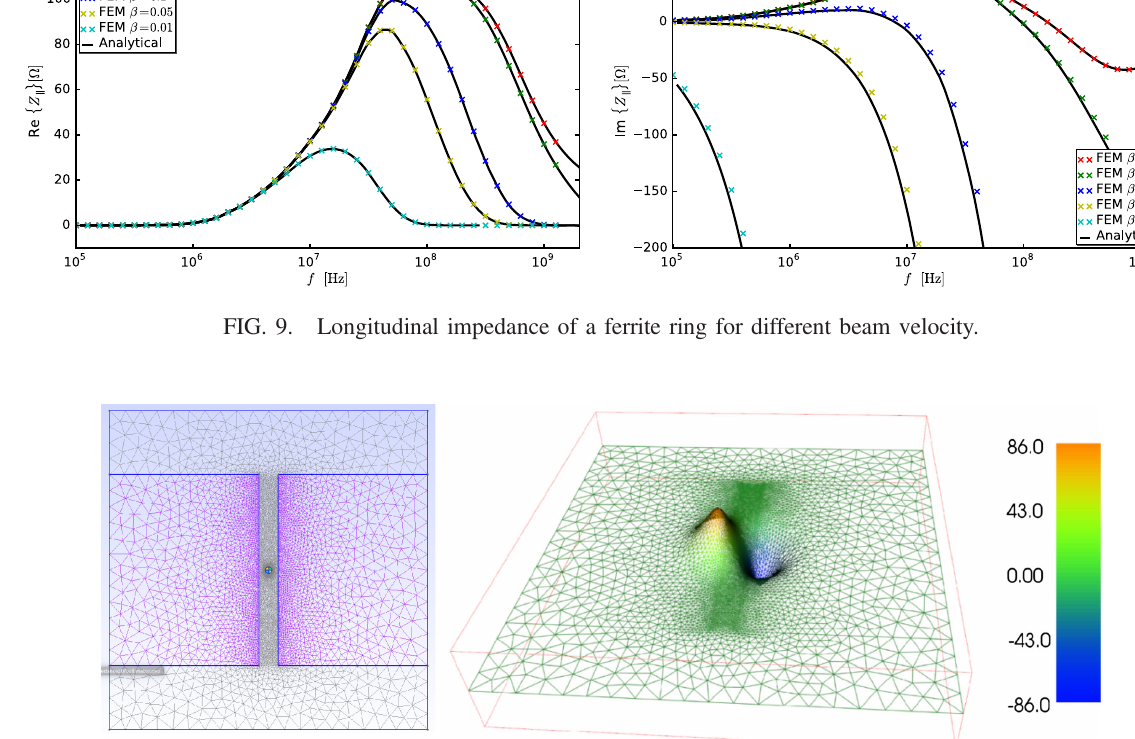
FIG. 10. Resistive collimator with 3 mm half gap and 3 cm half jaw height in a 10 cm × 10 cm bounding box. Mesh from GMSH (left), where the carbon jaws are in magenta and vacuum is in grey. The real part of the longitudinal electric field (in V = m = Hz) for horizontal dipole excitation at 1 MHz and β ¼ 0 . 1 is depicted on the